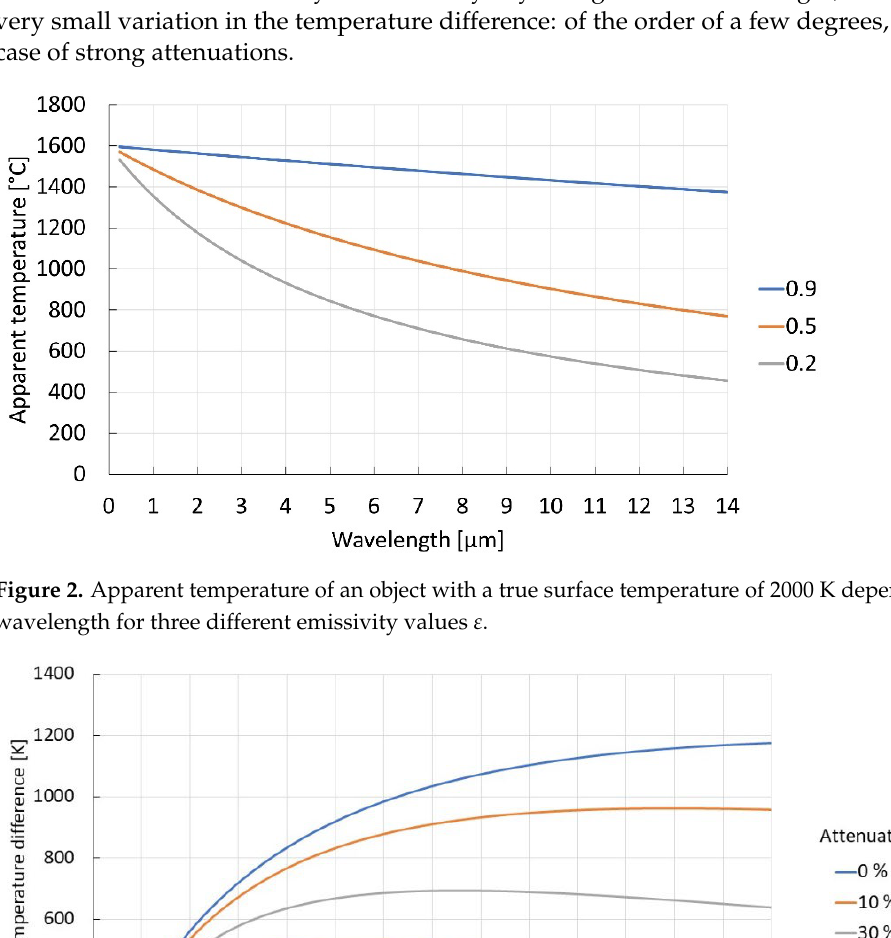
Figure 2. Apparent temperature of an object with a true surface temperature of 2000 K depending on wavelength for three different emissivity values . 𝜺𝜺 The effect of attenuation along the line of sight on the apparent temperature differ-